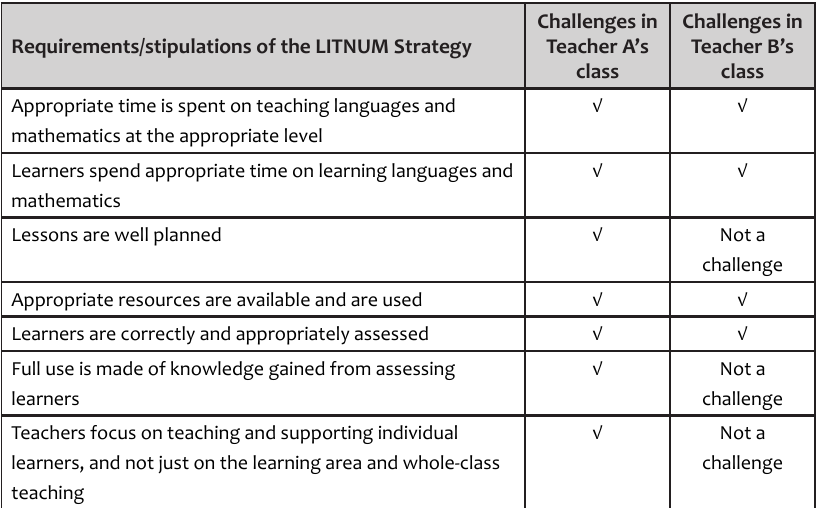
Table 3 Challenges related to the LITNUM